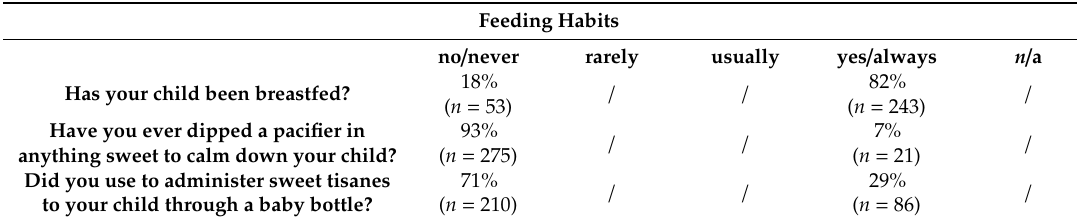
Table 1. Questions and data on feeding